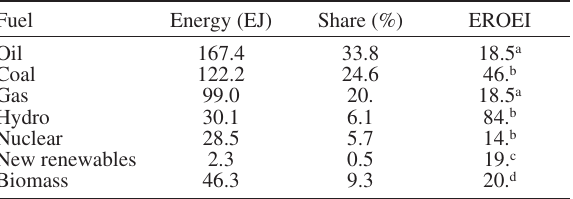
Table 4. – Primary energy produced from different sources in 2005 (Grubler et al. 2012), their share in the mix and their EROEI esti- mated by different sources: a, Gagnon et al. (2009); b, Hall et al. 2014; c, based on Hall et al. (2014) and Vant-Hull (1985); d, based on Gagnon